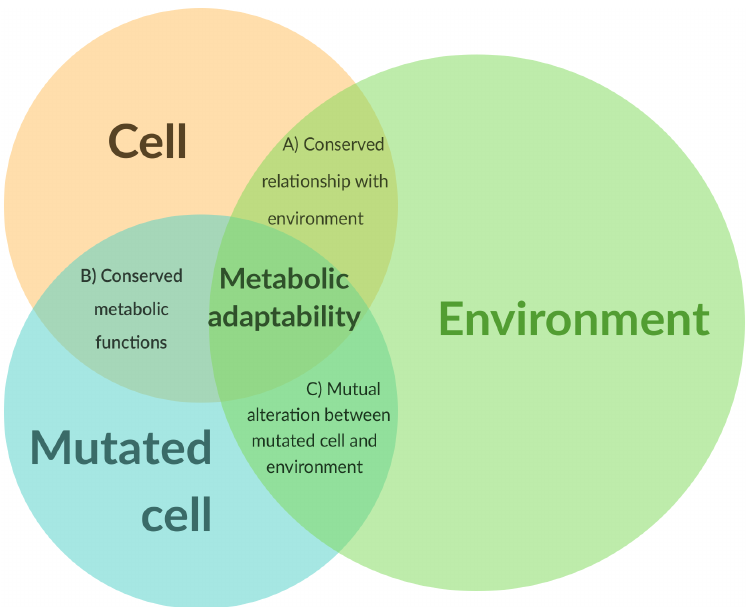
Figure 1. Schematic representation of metabolic adaptability. Metabolic adaptability lies at the interface of the relationship between the cell’s structure and its environment, and is beyond only